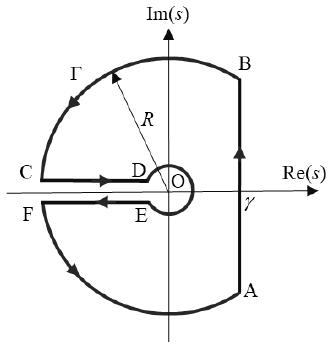
Figure 2. Contour integral on the complex plane of s .